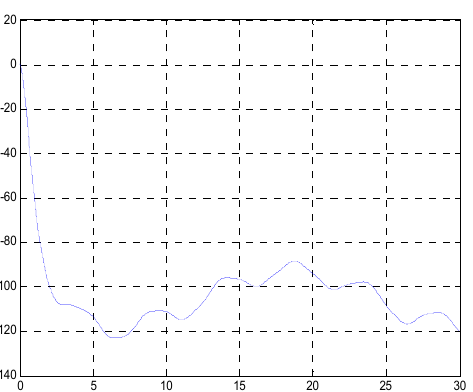
Figure 5. Torque produced.